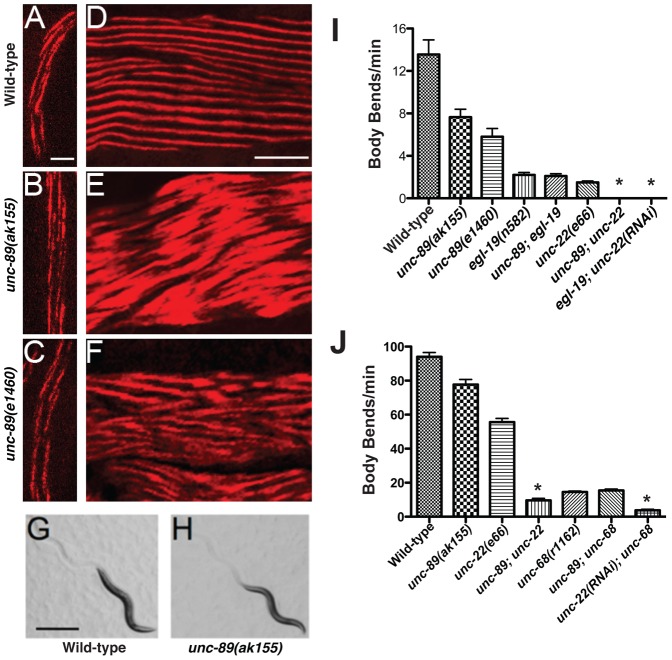
UNC-89 is required for sarcomere organization and function.(A–C) Representative L1 animals labeled with an anti-myosin heavy chain-A (MHC-A) antibody. Scale bar = 2 µm. Anterior is up. (A) Wild-type animal showing normal MHC-A organization. (B, C) unc-89 mutants indicating normal distribution of MHC-A. (D–F) Representative adult animals labeled with anti-MHC-A antibody. Scale bar = 5 µm. Anterior is to the left. (D) Wild-type animal showing normal MHC-A organization. (E, F) unc-89 mutants have severely disorganized sarcomeres. Representative (G) wild-type and (H) unc-89(ak155) adult animals displaying normal sinusoidal locomotion. Scale bar = 500 µm. (J) Body bend analysis of animals crawling. egl-19(n582); unc-89(ak155) display a similar rate of body bends as compared to egl-19(n582) single mutants. However, unc-89(ak155); unc-22(e66) and egl-19(n582)unc-22(RNAi) are completely paralyzed and do not produce any body bends, which is significantly worse than the single mutants (* p<0.05). (K) Body bend analysis of animals swimming. unc-89(ak155); unc-68(r1162) mutants show a similar rate of body bends as unc-68(r1162) single mutants (p = 0.48). However, unc-89(ak155); unc-22(e66) double mutants show a significant decrease in body bends compared to unc-22(e66) mutants alone (p<0.001).